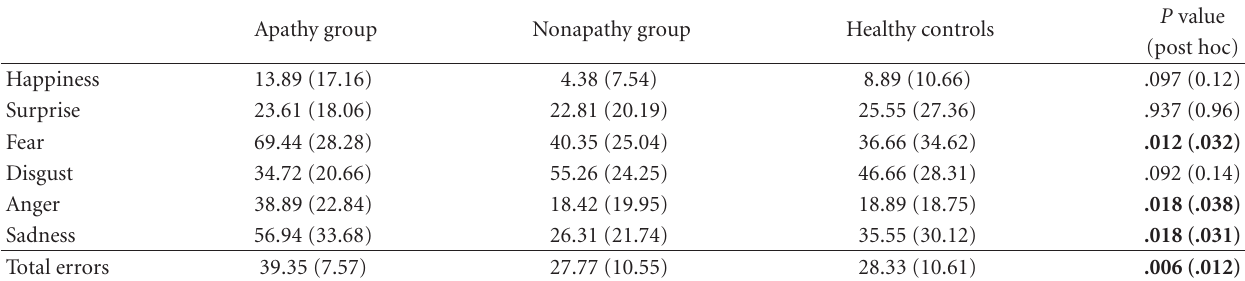
Table 2: Errors (%) on the facial emotion recognition